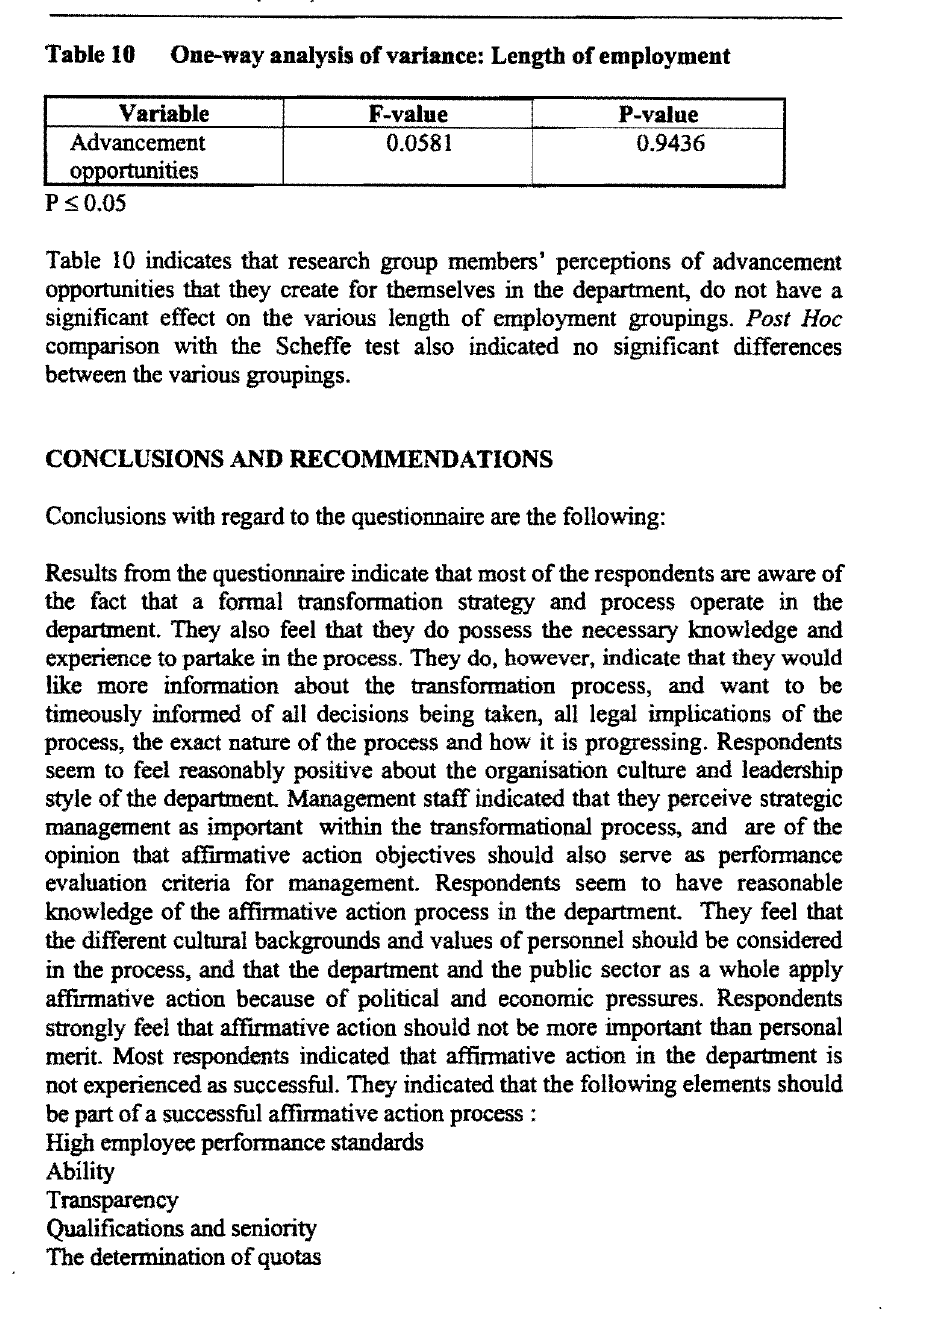
Table 10 indicates that research group members' perceptions of advancement opportunities that they create for themselves in the department, do not have a significant effect on the various length of employment groupings. Post Hoc comparison with the Scheffe test also indicated no significant differences between the various